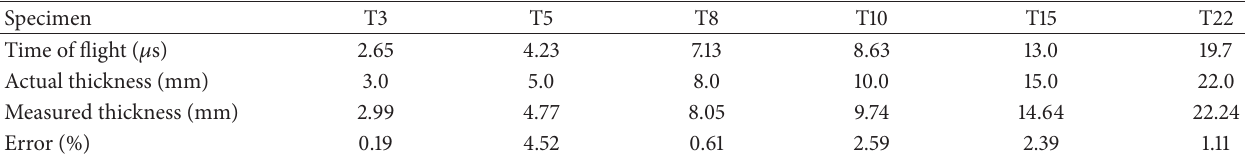
Table 2: The time of flight and the measured thickness of PVC sheets.